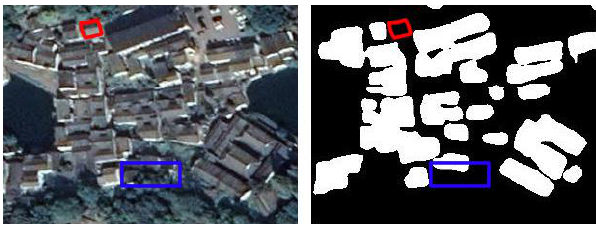
Figure 8 . Misidentification in semantic